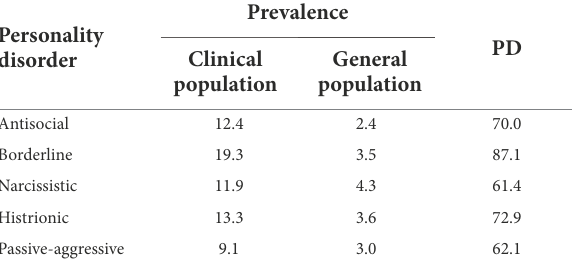
TABLE 6 Prevalence (%) of dramatic and emotional personality disorders and psychological distress.